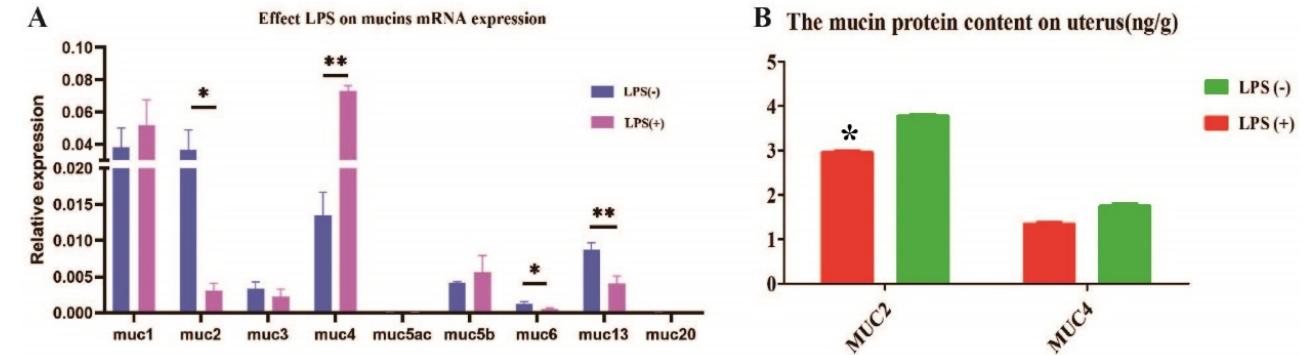
Figure 1. Effect of LPS on mucin mRNA and protein content of the endometrium in LPS (+) and LPS (-) groups. ( A ) Effect LPS on mucins mRNA expressions; ( B ) The mucin protein content on uterus. * Statistical difference between LPS (+) and LPS (-) groups in the same period ( p < 0.05); ** statistical difference between LPS (+) and LPS (-) groups in the same period ( p < 0.01).